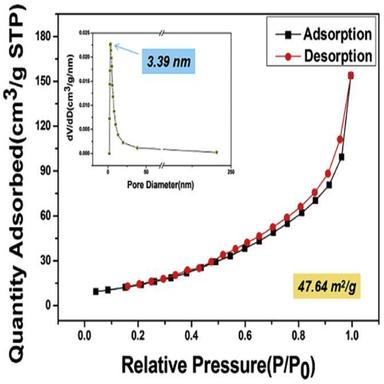
N2 adsorption-desorption isotherms and pore-size distribution graphs of NFO/ GNSs-10.